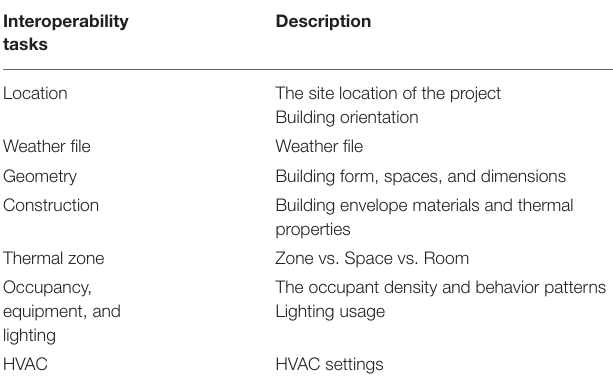
TABLE 2 | Interoperability tasks under